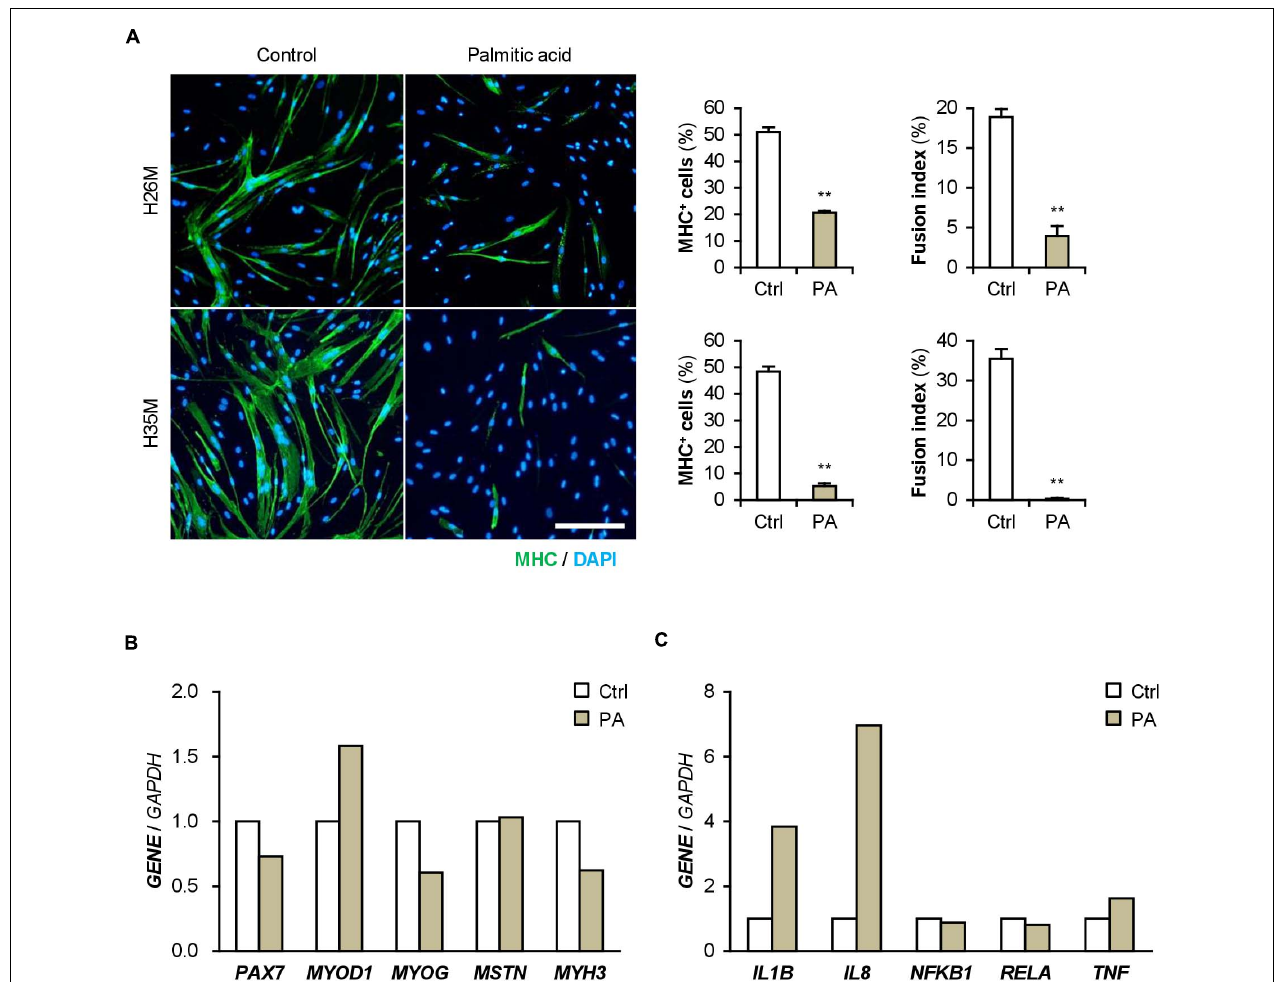
FIGURE 7 | Palmitic acid (PA) deteriorates myoblast differentiation. (A) Representative immunofluorescent images of the H26M and H35F myoblasts differentiated in DIM-NG with PA for 2 days. Scale bar, 200 µ m. Ratio of MHC + cells and multinuclear myotubes were quantified. ** p < 0.01 vs. control (Student’s t -test); n = 4–6. (B,C) qPCR results of gene expression in the H35M myoblasts differentiated in DIM-NG with palmitic acid for 2 days. Mean value of control group was set to 1.0 for each gene; n =